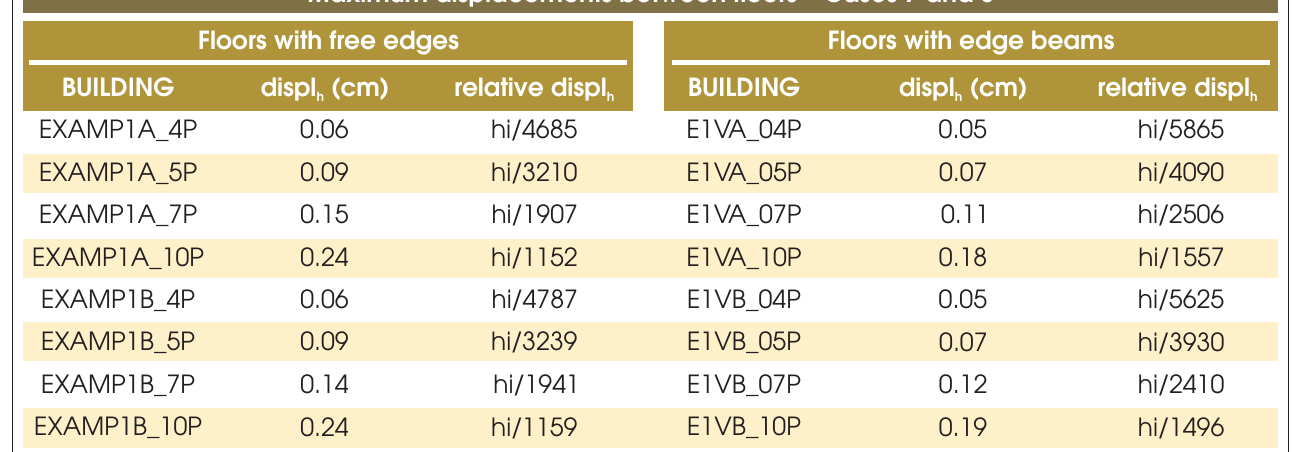
Table 11 – Values of maximum displacements between floors, in cm (cases 7 and 8)